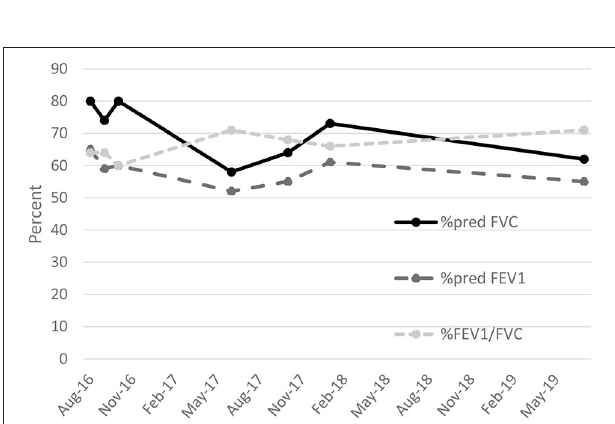
FIGURE 3 | Percent predicted forced expiratory volume in 1 second (%pred FEV 1 ). percent predicted forced vital capacity (%pred FVC), and ratio of FEV 1 to FVC expressed as a percent (%FEV 1 /FVC) for patient diagnosed